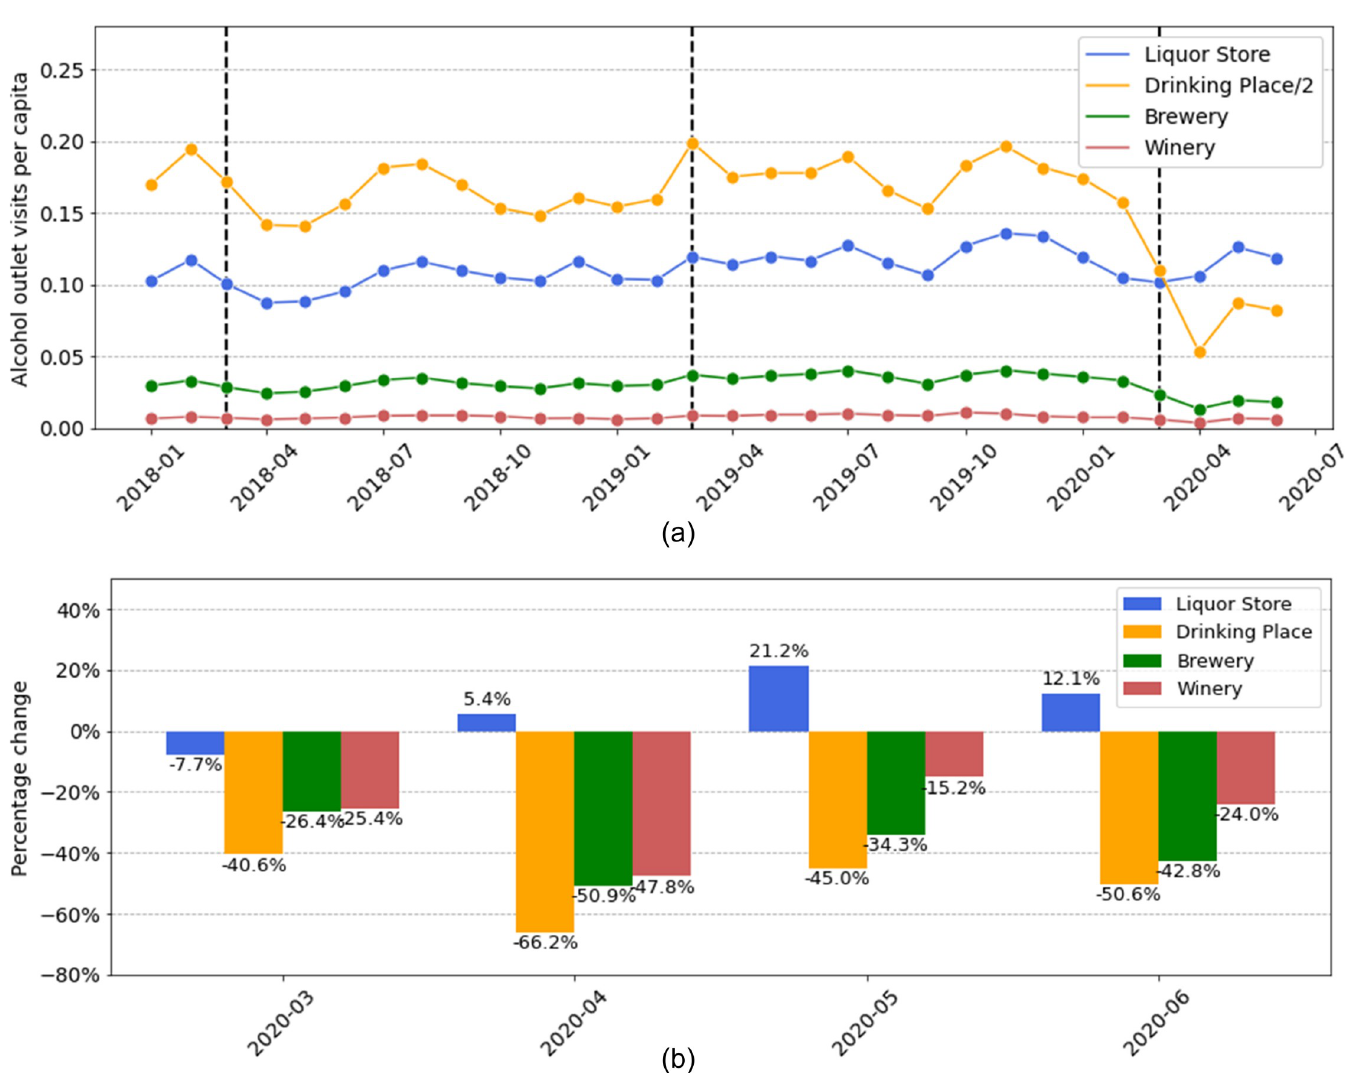
Fig 9. Visitation behavior to the four types of alcohol outlets in the U.S. during the first months of COVID-19. (a) Time series describing the per capita visits for each month from January 2018 to June 2020 (which is averaged across 16 states). The dashed lines indicate the month of March in 2018, 2019, and 2020. Note that visits to drinking places are divided by 2 so that all curves can be shown within a similar scale for clear visualization. (b) For the months of March, April, May, and June 2020, we depict the changes to per capita visits. For each month, the percentage change was computed relative to the average value for the same month of 2018 and